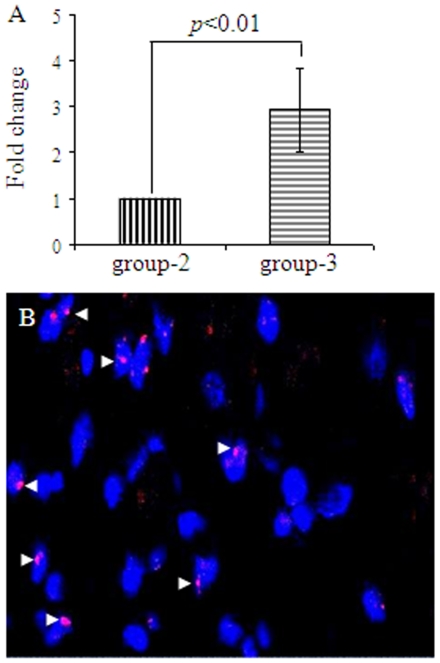

ShhMSCs survival in the infarcted heart.(A) Real-time PCR for sry-gene showed improved survival of ShhMSCs in the infarcted rat heart on day-7 post engraftment as compared with EmpMSCs. Basal DMEM injected animal hearts showed no detection of sry-gene expression and served as a negative control. (B) FISH using rat y-chromosome specific probe labeled with red fluorescence to visualize transplanted male ShhMSCs on day-7 post-engraftment in group-3.